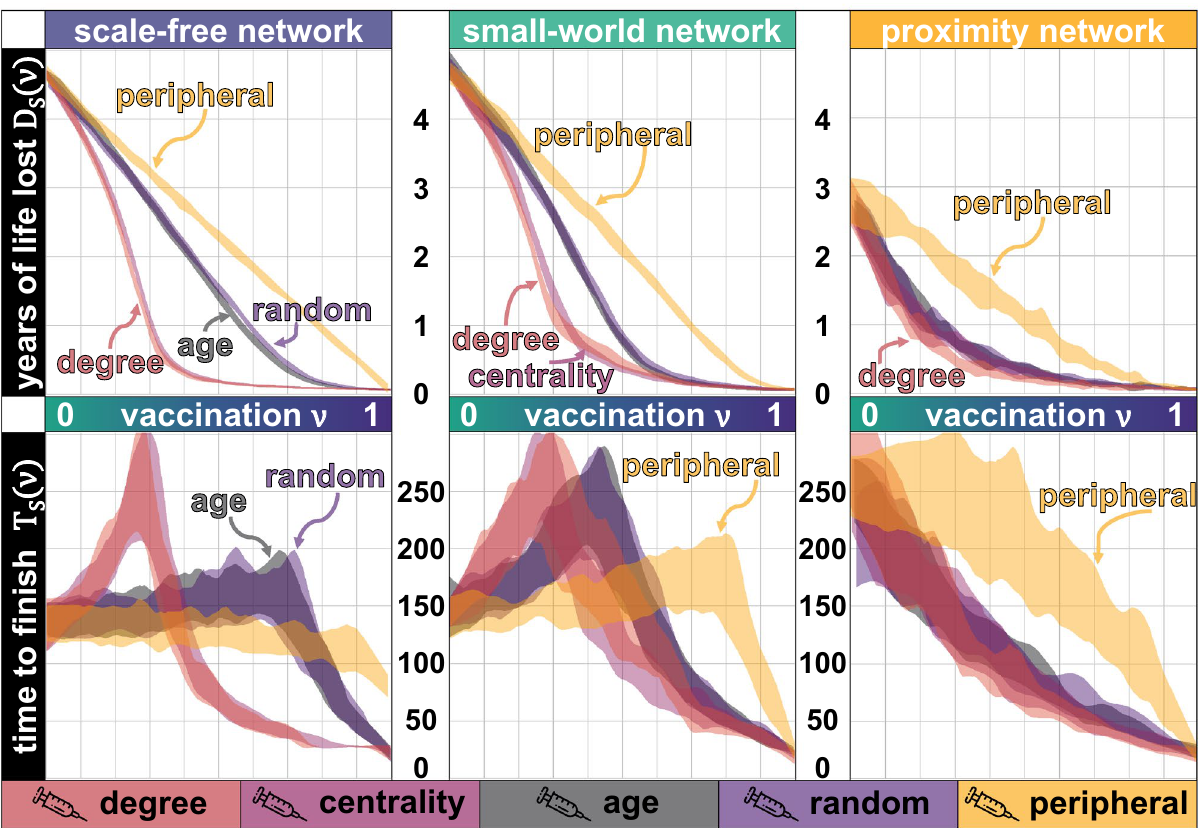
Figure 2. Years of life lost D S (ν) (vertical axis) for different vaccination rates ν (in the top panel), and the corresponding time T S (ν) (vertical axis) with the same vaccination rate (in the bottom panel). Three network topologies are tested, a scale-free network in the left (with power p = 1 ), a small-world network in the middle (where the rewiring probability is r = 0.1 ) and a proximity network in the right, all networks with an average node degree of 6. Each strategy is simulated 500 times with N = 5000 individuals, with a probability of infecting neighbouring nodes at each step of π = 0.05 and with a varying vaccination rate ν . The lethality of the virus increases with φ = 0.05 , meaning that a person with y years does not survive after being infected with a probability of 0.05 y